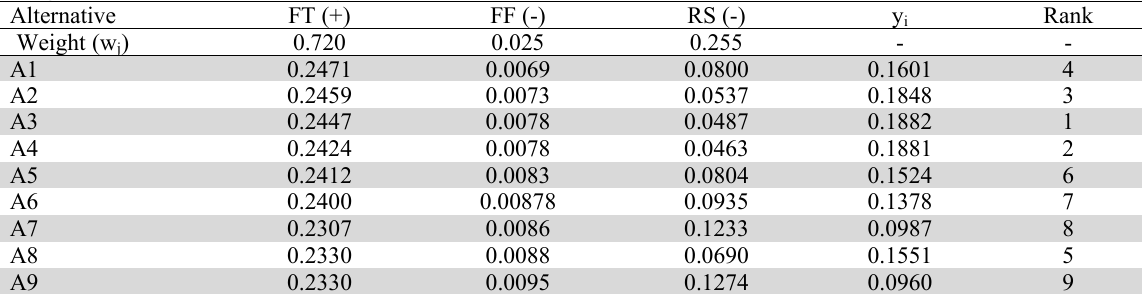
Weighted assessment values (y i